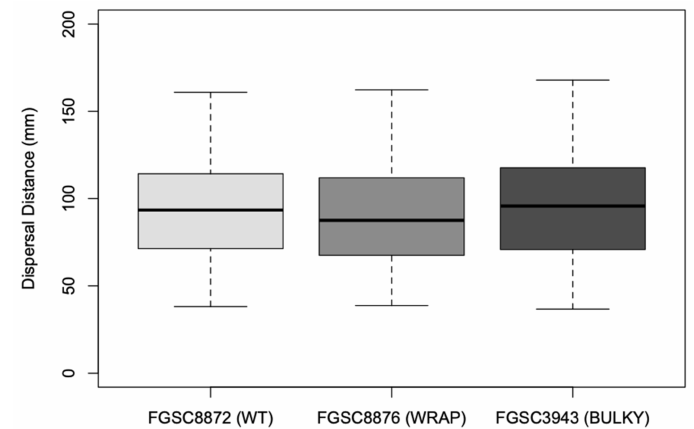
Figure 9. Distance in mm to the center of each colony on sorbose + fructose + glucose (SFG) medium from the center of each nitrocellulose membrane. The dataset includes two biological replicates. The box shows the 25th and 75th percentiles, with the median denoted as a line inside. The whiskers represent the range of data. The t -test results for pairs are as follows: WT–Wrap, p = 0.0587; Wrap–Bulky, p = 3.101 × 10 − 5 ; WT–Bulky, p =